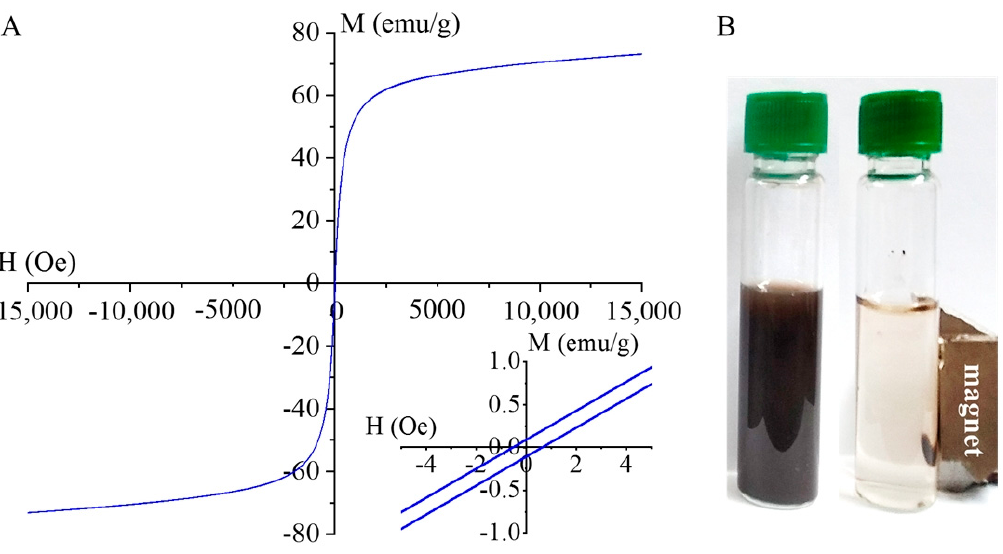
Figure 5. Magnetization curve of MnFe 2 O 4 (573 K) ( A ) and its magnetic separability by using a magnetic field ( B ).